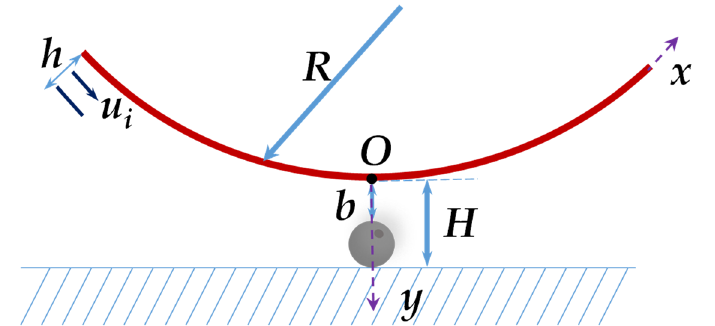
Figure 3. The two-dimensional wall jet on a curved surface. A curvilinear x-y coordinate system was added in the figure together with some parameters. The h , u i , R , b and H represents the jet slot height, initial velocity, curvature radius of the curved surface, jet half-width and distance between the curved surface and the ground, respectively.